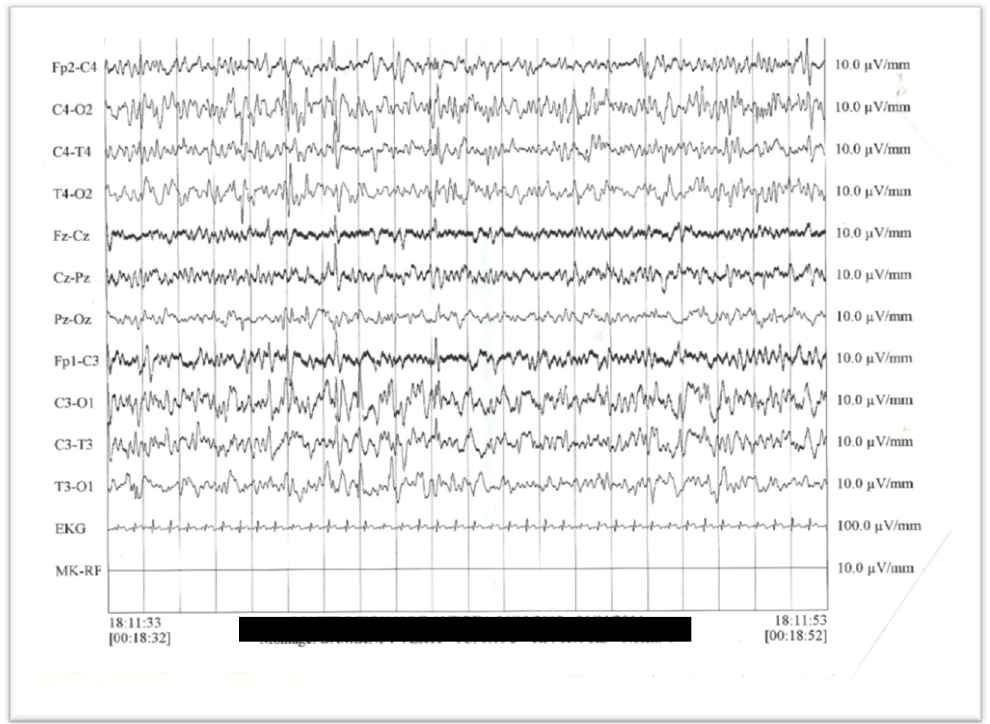
Figure 2. The electroencephalogram (EEG) obtained when the patient was 3 years old reveals diffuse cortical electrical anomalies in the centro-temporal areas of both cerebral hemispheres; theta-delta band rhythms, with intermittent repetitions of sharp waves, are mainly evident on the left hemisphere where they assume a subcontinuous morphology.